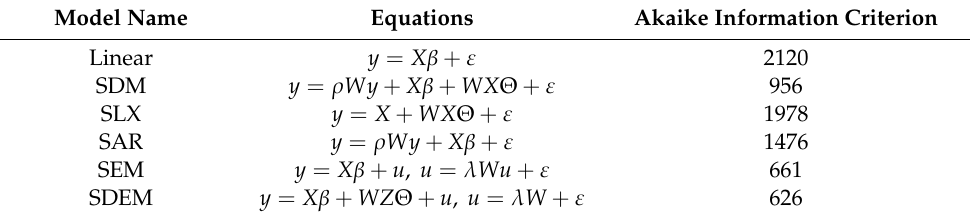
Table 1. Spatial Regression Models and Tests for Optimal Model